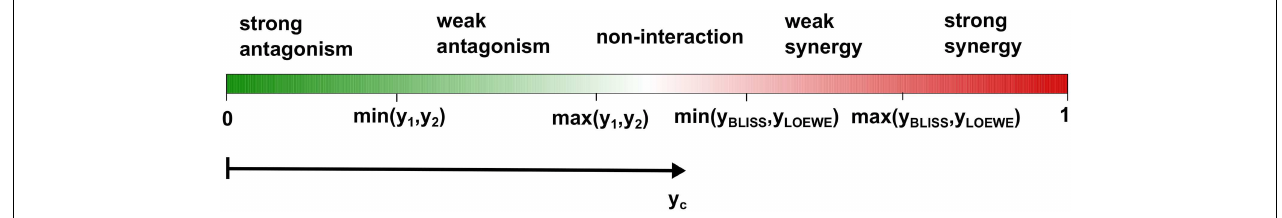
FIGURE 1 | The proposed terminology for classifying drug interactions. Using the interaction barometer allows a direct comparison between different drug combinations in terms of their degrees of interaction as well as their combination responses. If the observed drug combination effect y c is lower than the maximum single drug effect max ( y 1 , y 2 ) but higher than the minimum effect min ( y 1 , y 2 ) , then the combination is called weak antagonism; if y c < min ( y 1 , y 2 ) it is called strong antagonism. To classify synergy, we consider the Bliss and Loewe models, with the expected effects denoted as y BLISS and y LOEWE , respectively. If max ( y 1 , y 2 ) < y c < min ( y BLISS , y LOEWE ) , then we call the combination as non-interaction; if